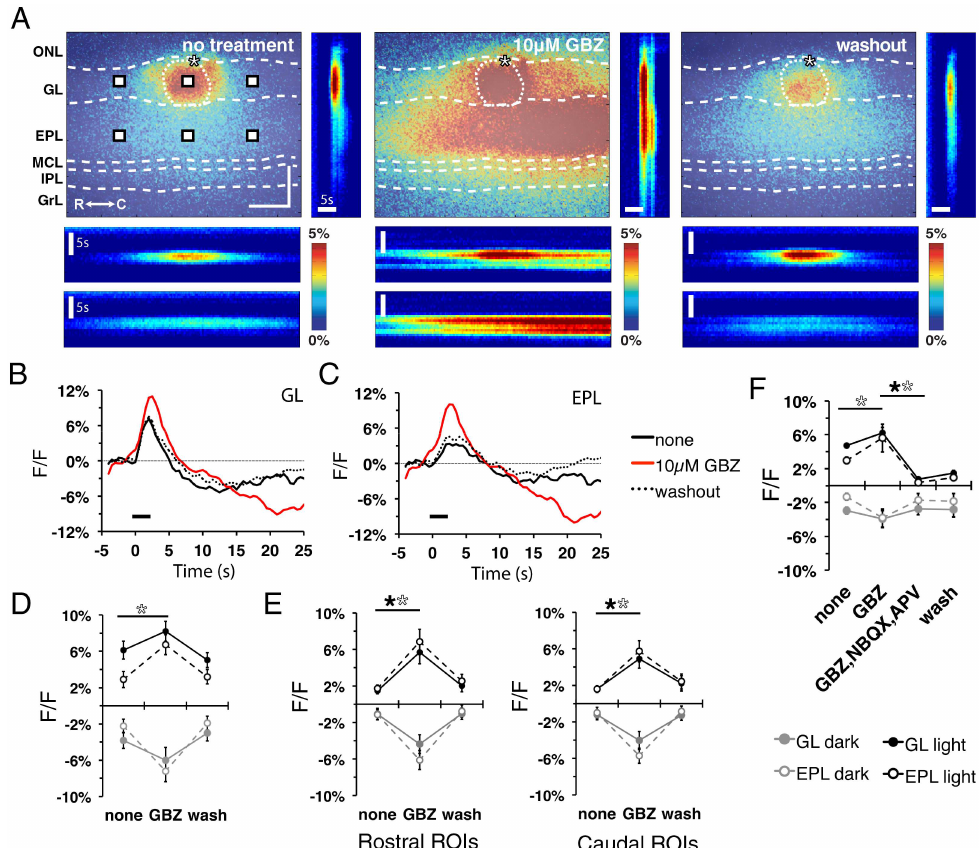
stimulationinitiation.ONL, olfactory nerve layer; GL, glomerular layer; EPL, external plexiform layer; MCL, mitral cell layer; IPL, internalplexiformlayer; GrL, granulecell layer; R, rostral; C, caudal. Asterisk, tip of the stimulating electrode.Targeted glomerulusindicatedby dashed circle. GBZ treatment increasedtranslaminar and lateral signal spreadacross the GL and EPL. Scale bars = 150 μ m. (B and C) ROI traces from the (B) GL and (C) EPL from all treatment conditions indicatedin (A). Traces were generatedfrom central ROIs within the GL and EPL, as depictedin (A). Line: stimulus train delivery and duration. (D) Mean light phase(black) and dark phase (gray) signalsfrom central GL (solid) and EPL (dash) ROIs exhibitincreasesin amplitudefollowingGBZ treatment. (E) Mean light phase (black) and dark phase (gray) signalamplitudesfrom the rostral and the caudal ROIs of the GL (solid) and EPL (dash) as depictedin (A). Both rostral (left) and caudal (right) areas exhibitedamplitudeincreases followingGBZ treatment. (F) Additionaltreatment with 10 μ M NBQX and 50 μ M AP-V abolished the